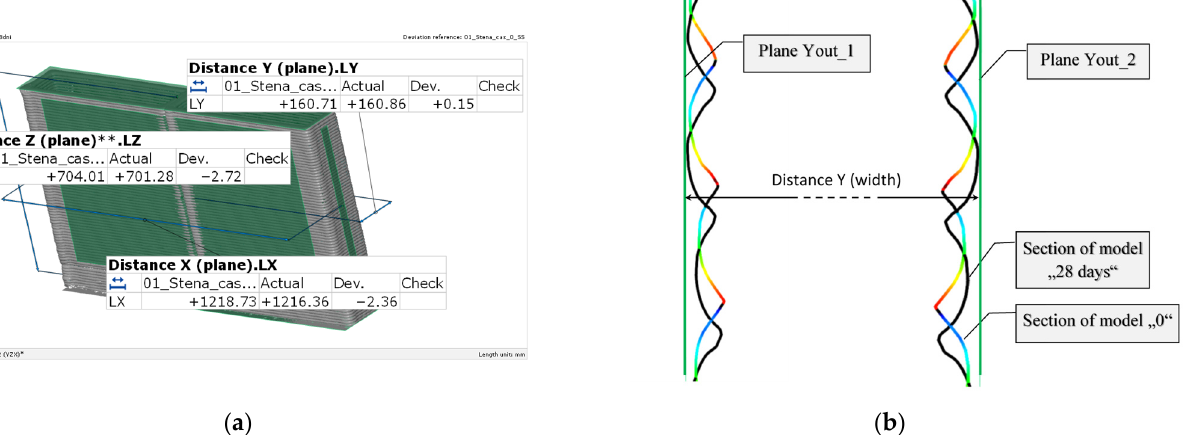
Figure 6. ( a ) Measurement of the dimensions of the wall element by the method of interlacing planes; ( b ) measurement of the dimensions between the fitting planes ( Y direction).